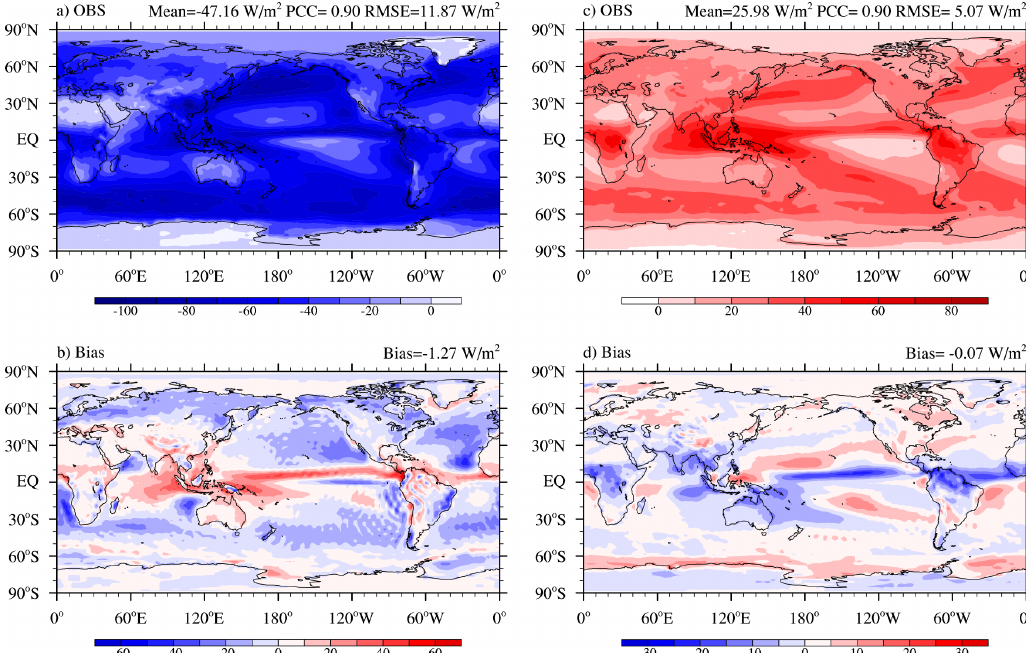
Figure 7. Annual mean TOA shortwave (a, b) and longwave (c, d) cloud radiative effect ( c, d ; unit: Wm − 2 ) derived from observations (a, c) and the model bias (b, d) . The observed radiation fields were derived from the Clouds and the Earth’s Radiant Energy System (CERES) dataset (Loeb et al., 2009).